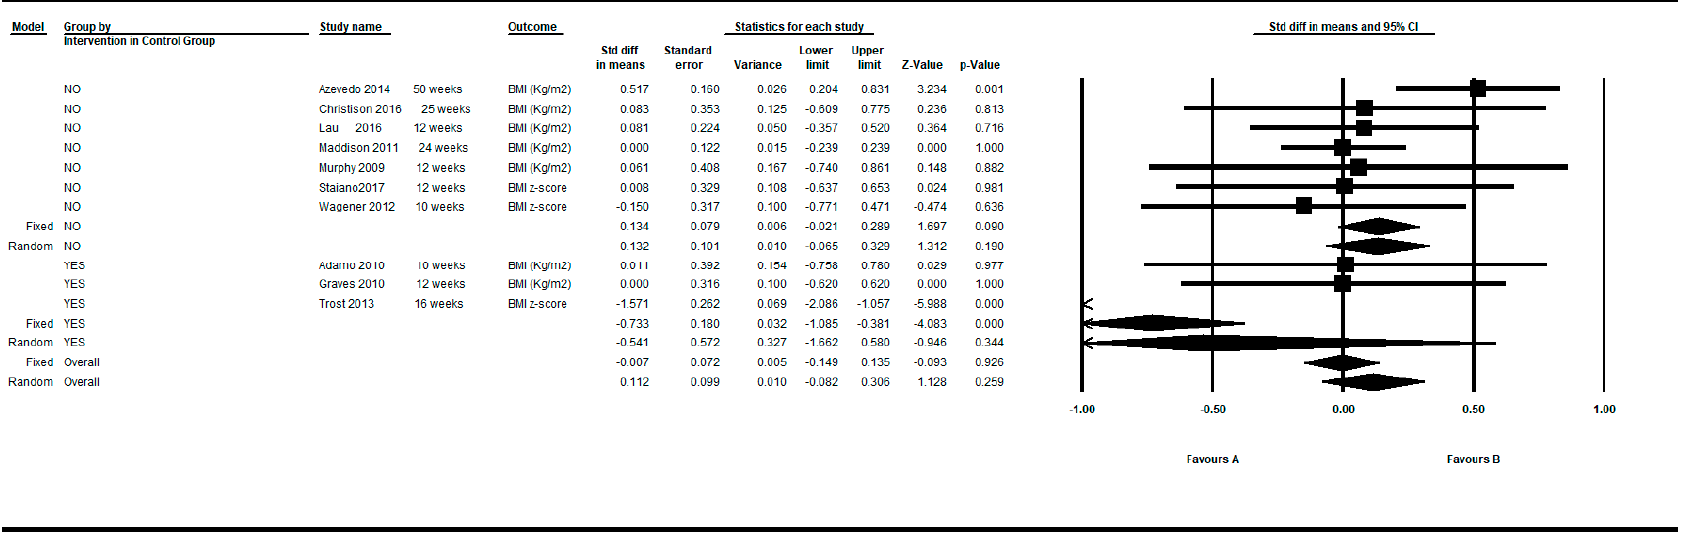
Figure 6. Pre-post intra-group difference in BMI in the control group. All measurements in the longest follow-up.